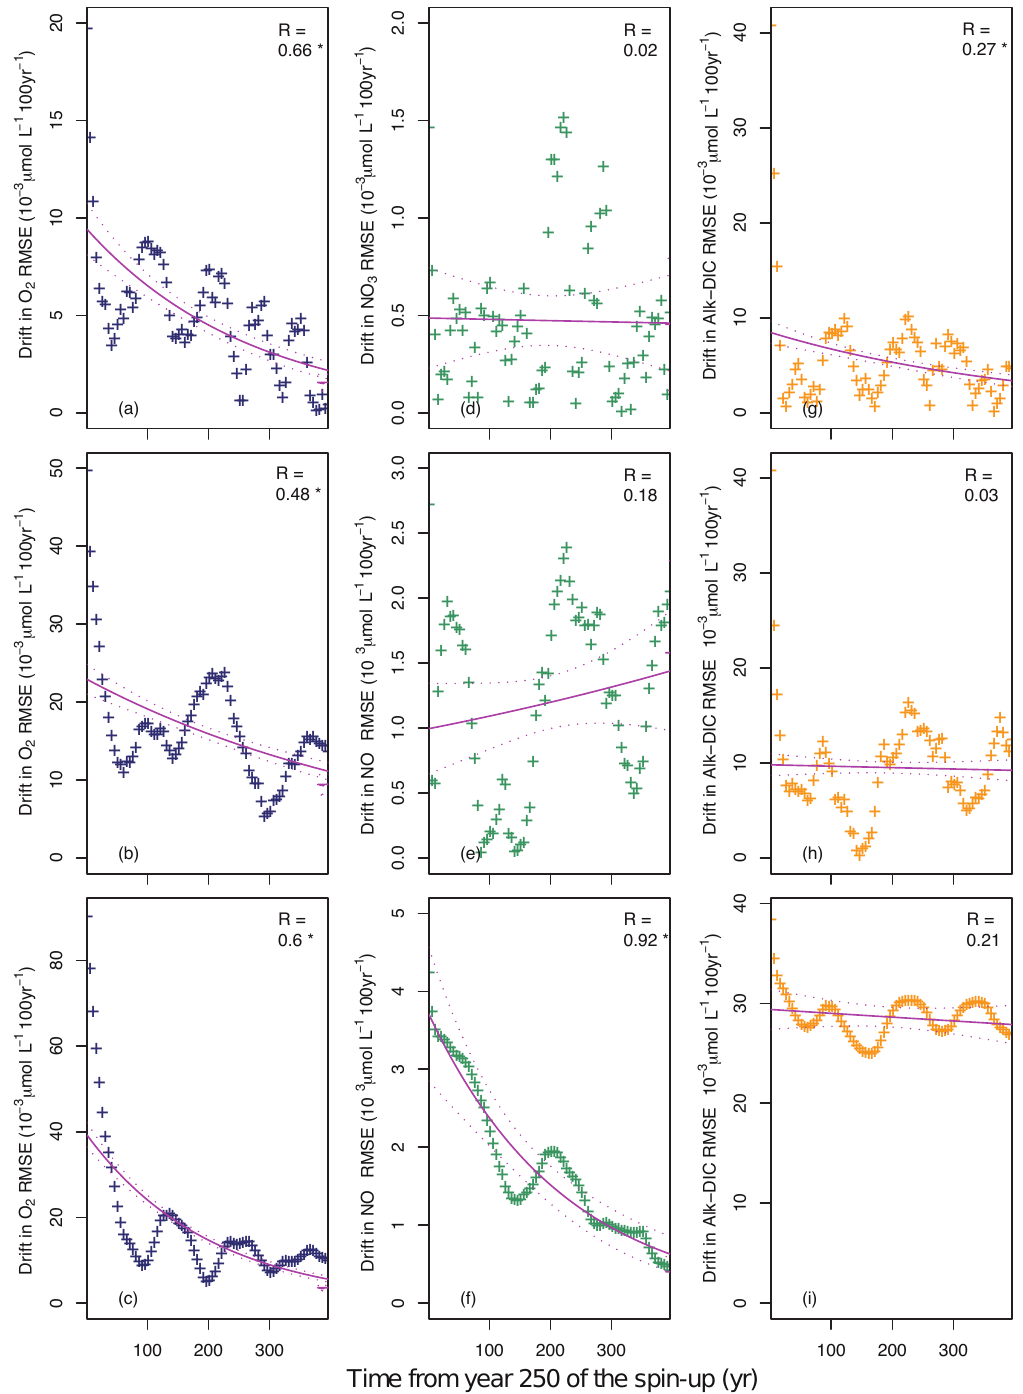
Figure 8. Temporal evolution of drift in root-mean squared error (RMSE) for dissolved oxygen (O 2 , blue crosses), nitrate (NO 3 , green crosses) and difference between alkalinity and dissolved inorganic carbon (Alk-DIC, orange crosses) during the 500-year long spin-up simulation of IPSL-CM5A-LR. Drift in RMSE is given at surface (a, b, c) , 150m (d, e, f) , and 2000m (g, h, i) for these three biogeochemical fields. Drift in RMSE is computed from time segments of 100 years beginning every 5 years from the beginning until year 400 of the spin-up simulation for O 2 , NO 3 and Alk-DIC tracers. The best-fit regressions between drifts in RMSE and spin-up duration over year 250 to 500 are indicated in solid magenta lines; their 90% confidence intervals are given by thin dashed envelopes. Least square correlation coefficients are tested against a one-tailed t-test with significance level of 90% and ∼ 15 effective degrees of freedom estimated with the formulation of Bretherton et al. (1999); ∗ indicates if a given least square correlation coefficient passes the